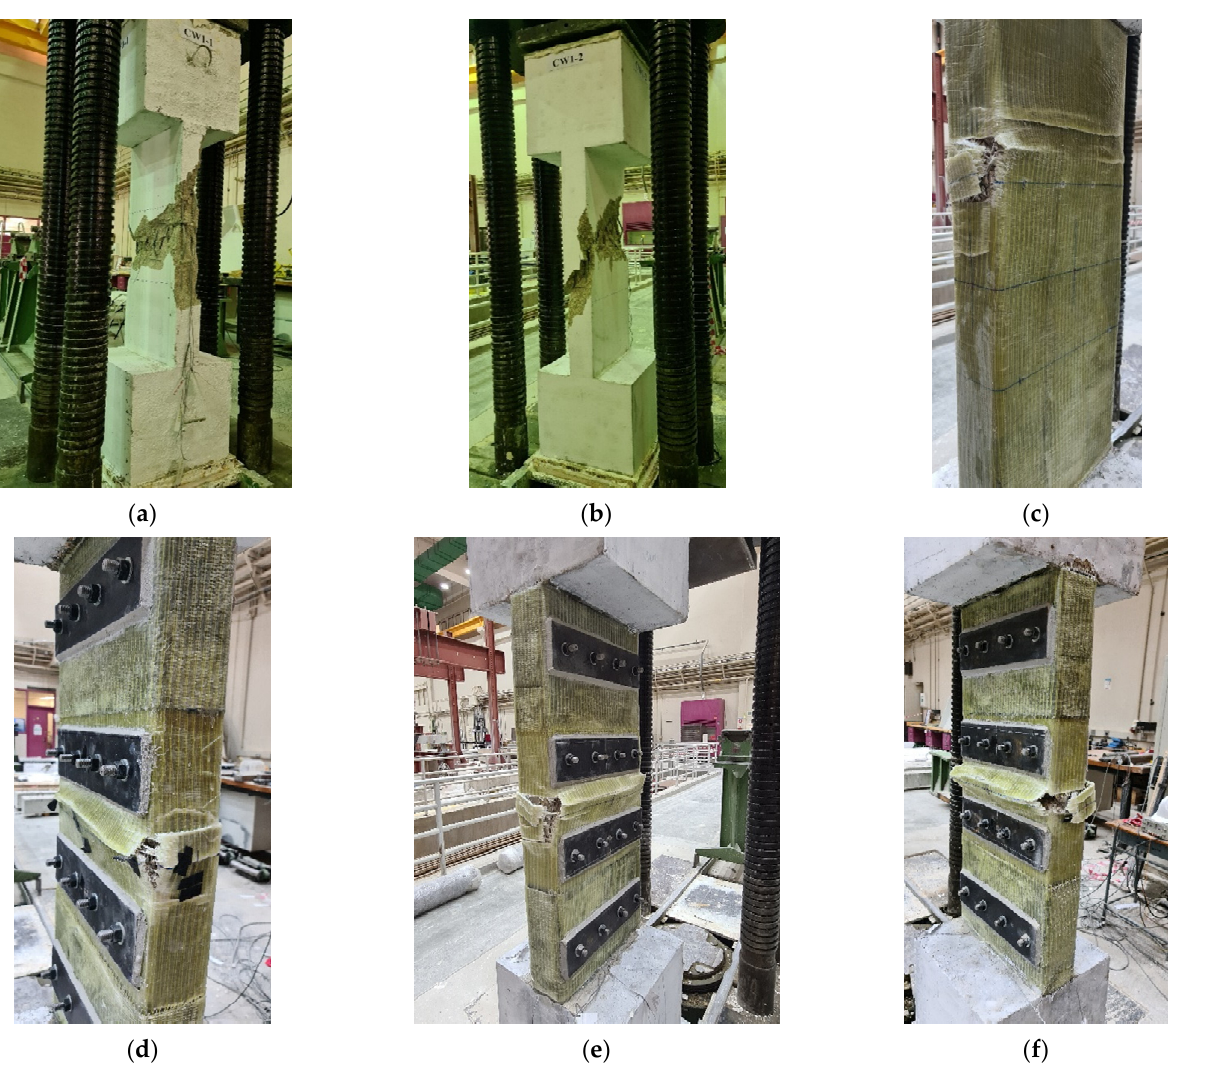
Figure 9. Load versus displacement curves for column specimens based on test results.